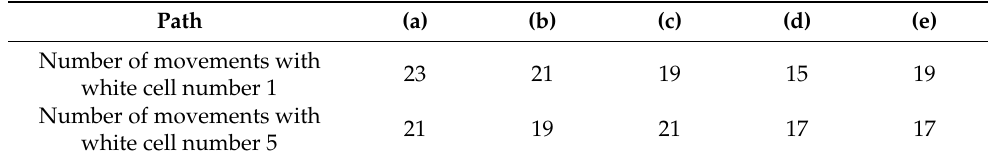
Table 1. The required number of movements based on selected empty cell and path in example 2.